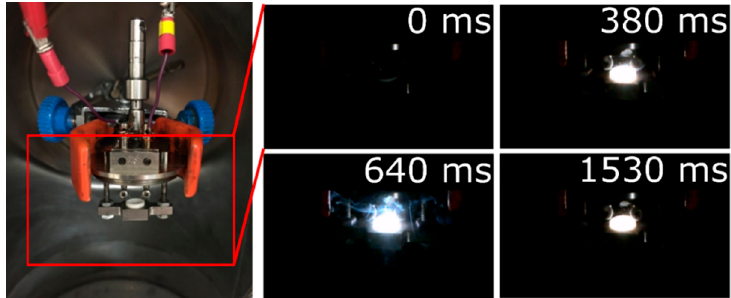
Figure 8. Still frames from a high-speed video of 40 µm Al:Zr PVD particles reacting in a larger chamber with 1 atm of O 2 and held in the assembly used during the bomb calorimeter experiments (Figure 3c).